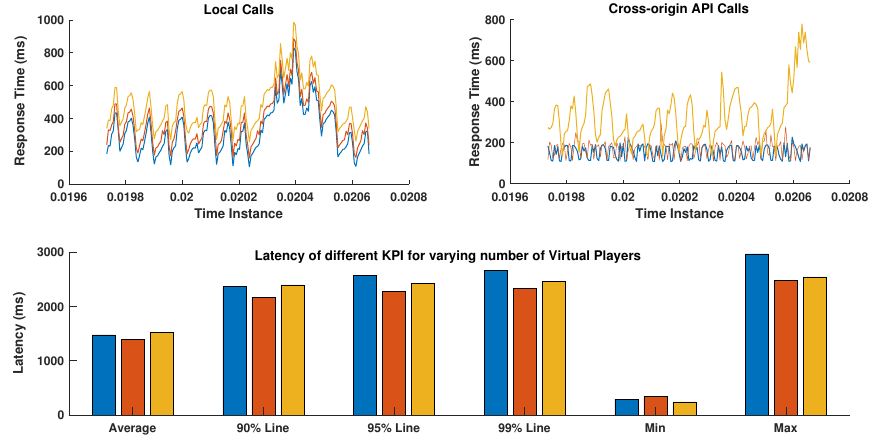
Figure 8. Quantitative analysis of resource endpoint access by simultaneous